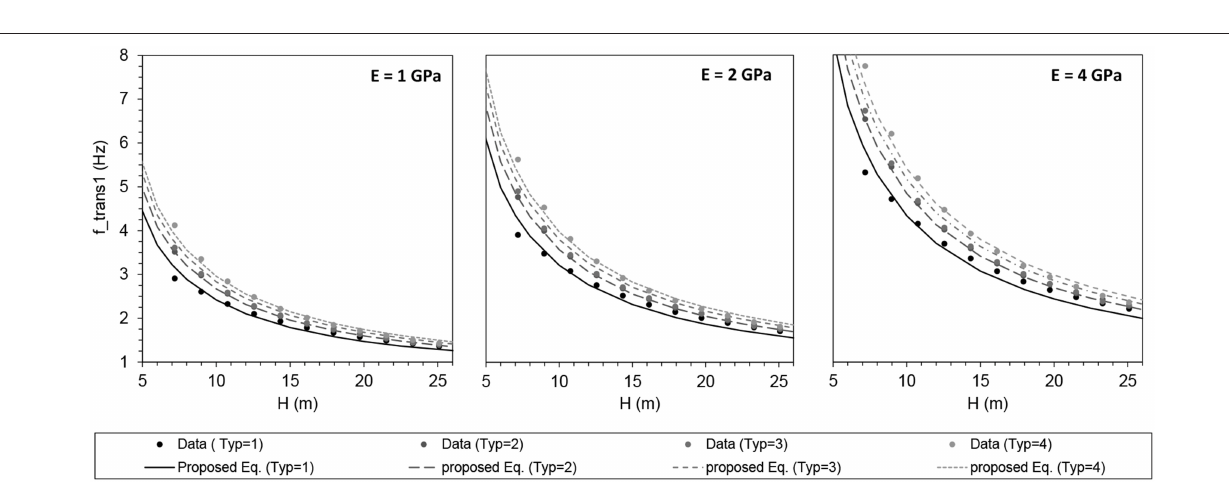
Frontiers in Built Environment |